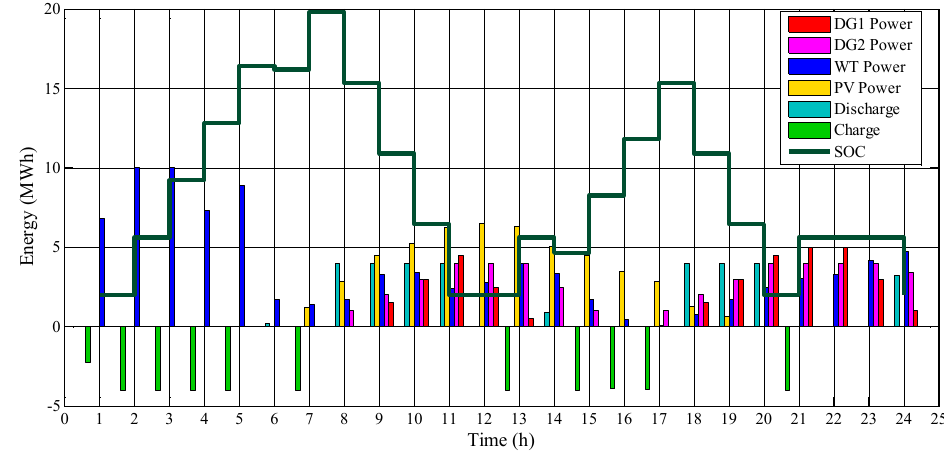
Figure 12. Optimal operating points of the AG’s local sources.